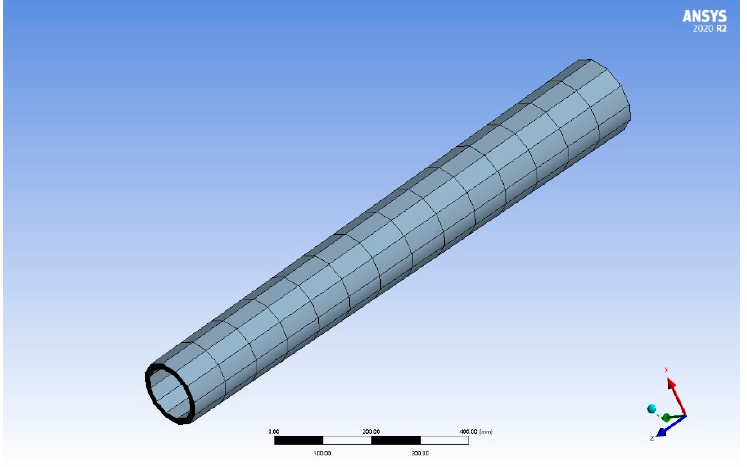
Figure 10. Schematic diagram of composite toolholder model ( ψ = 0, TR = 1, L/d = 12). Table 2. Effect of the change of the length-to-diameter ratio on the first-order inherent frequency of the boring bar under different TR values ( ψ = 0 ).